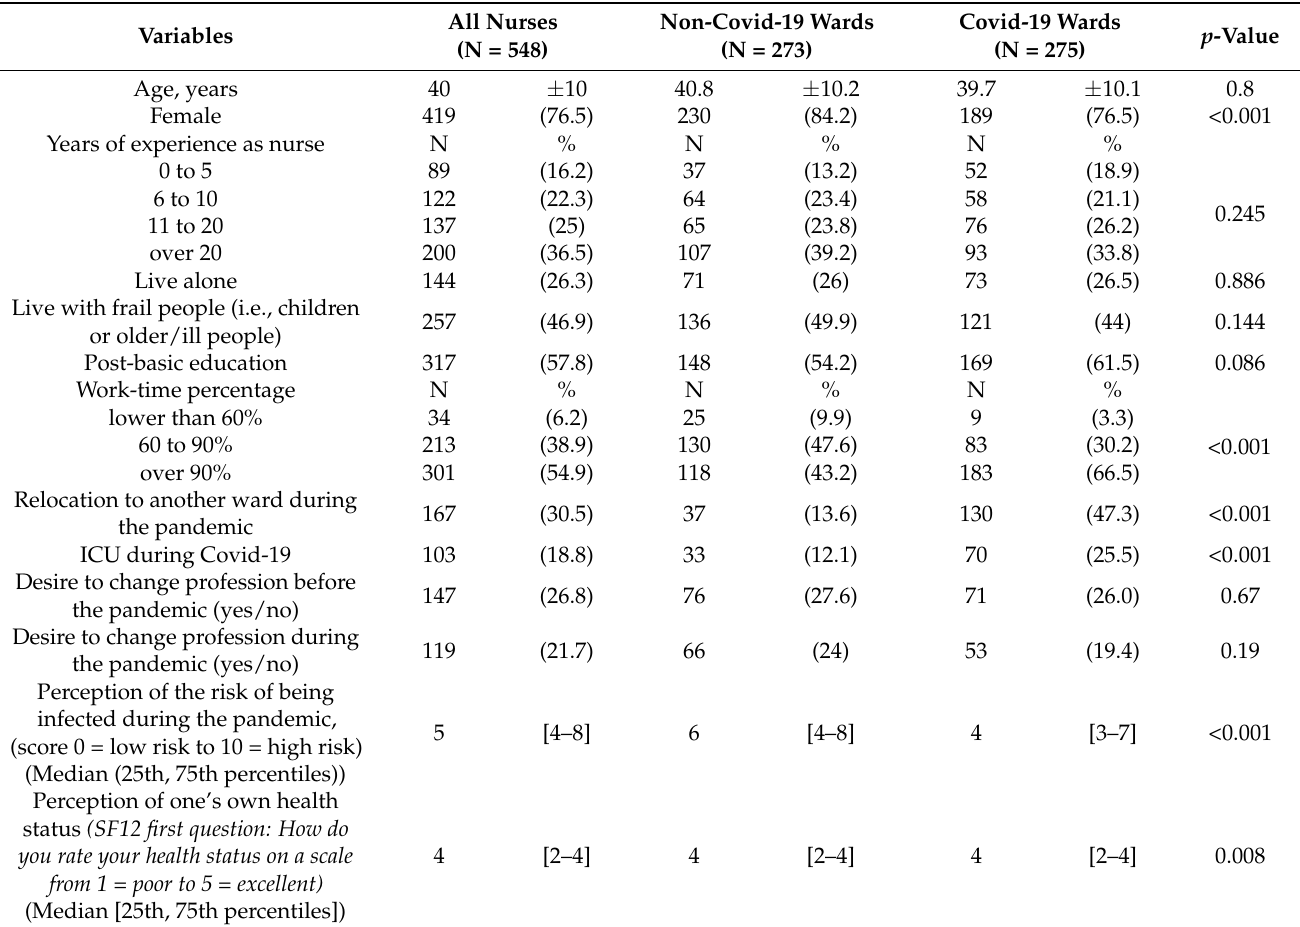
Table 1. Characteristics of the study